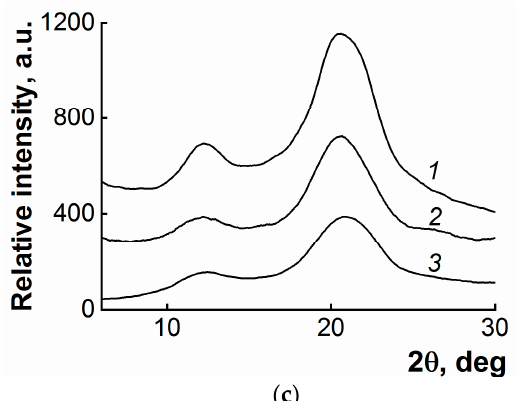
Figure 3. Equatorial diffractograms of cellulose (1) and composite fibers: ( a ) T-5 (2) and T-10 (3); ( b ) VT-5 (2) and VT-10 (3); ( c ) B-5 (2) and B-10 (3).